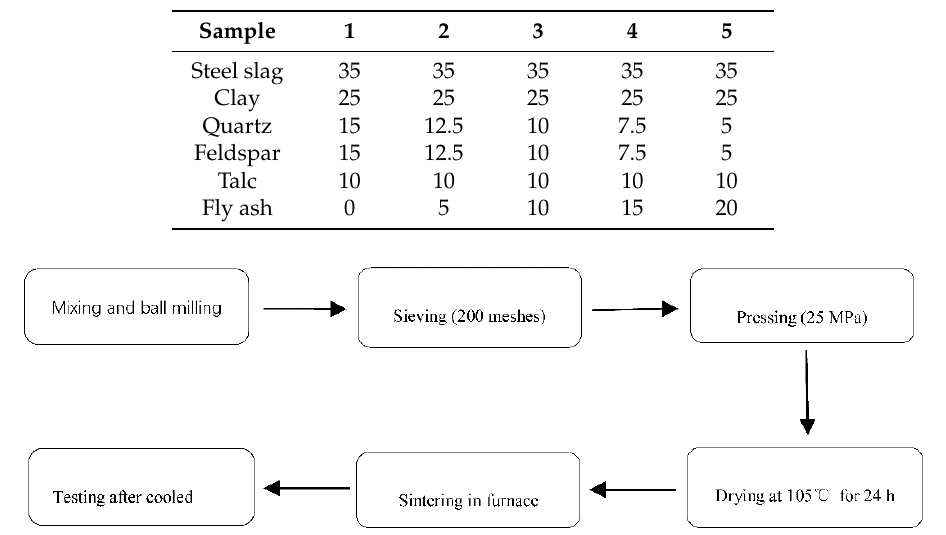
Table 2. Batch compositions of the samples (wt %).